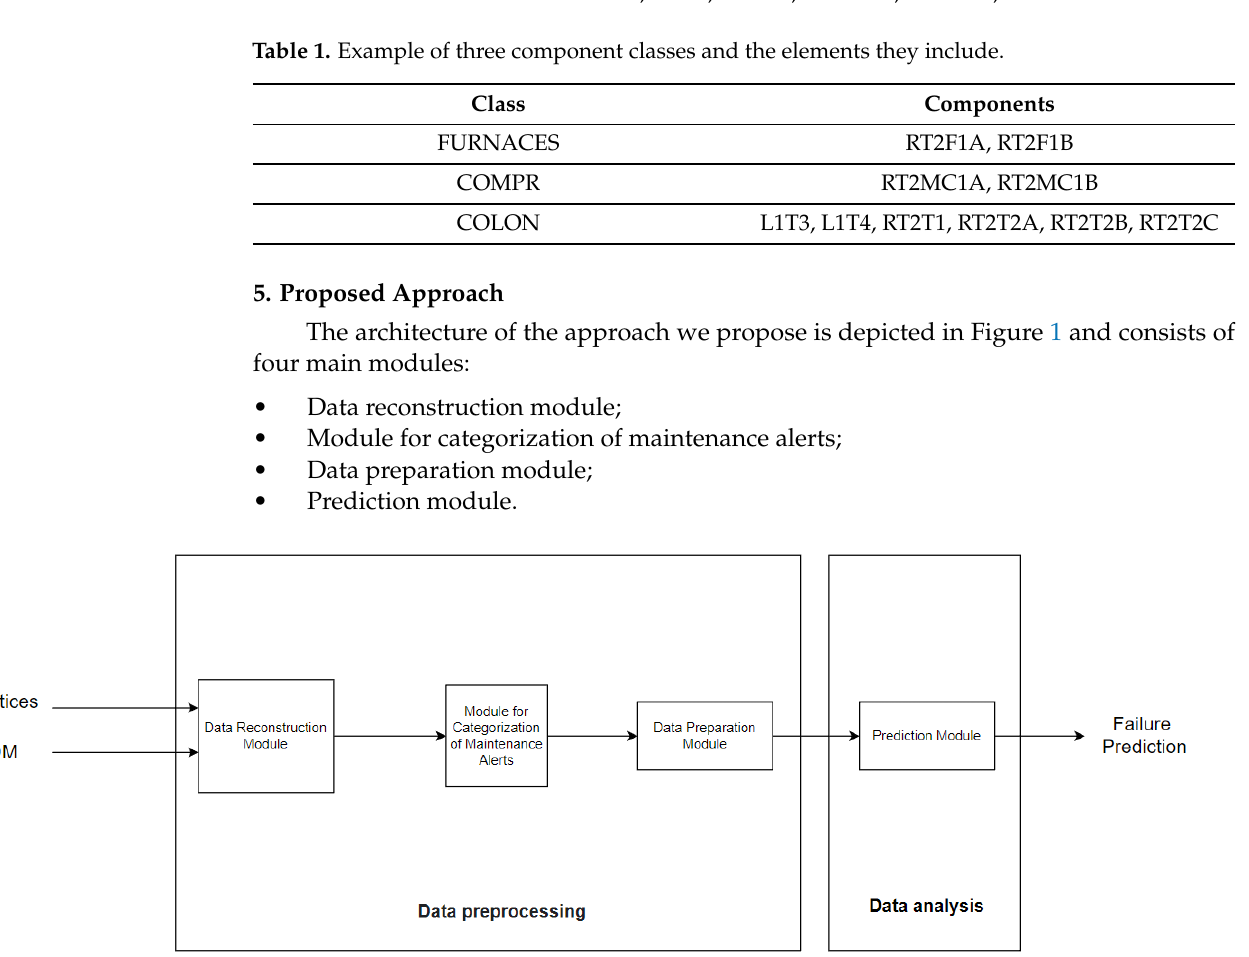
Figure 1. Flow chart of the four main